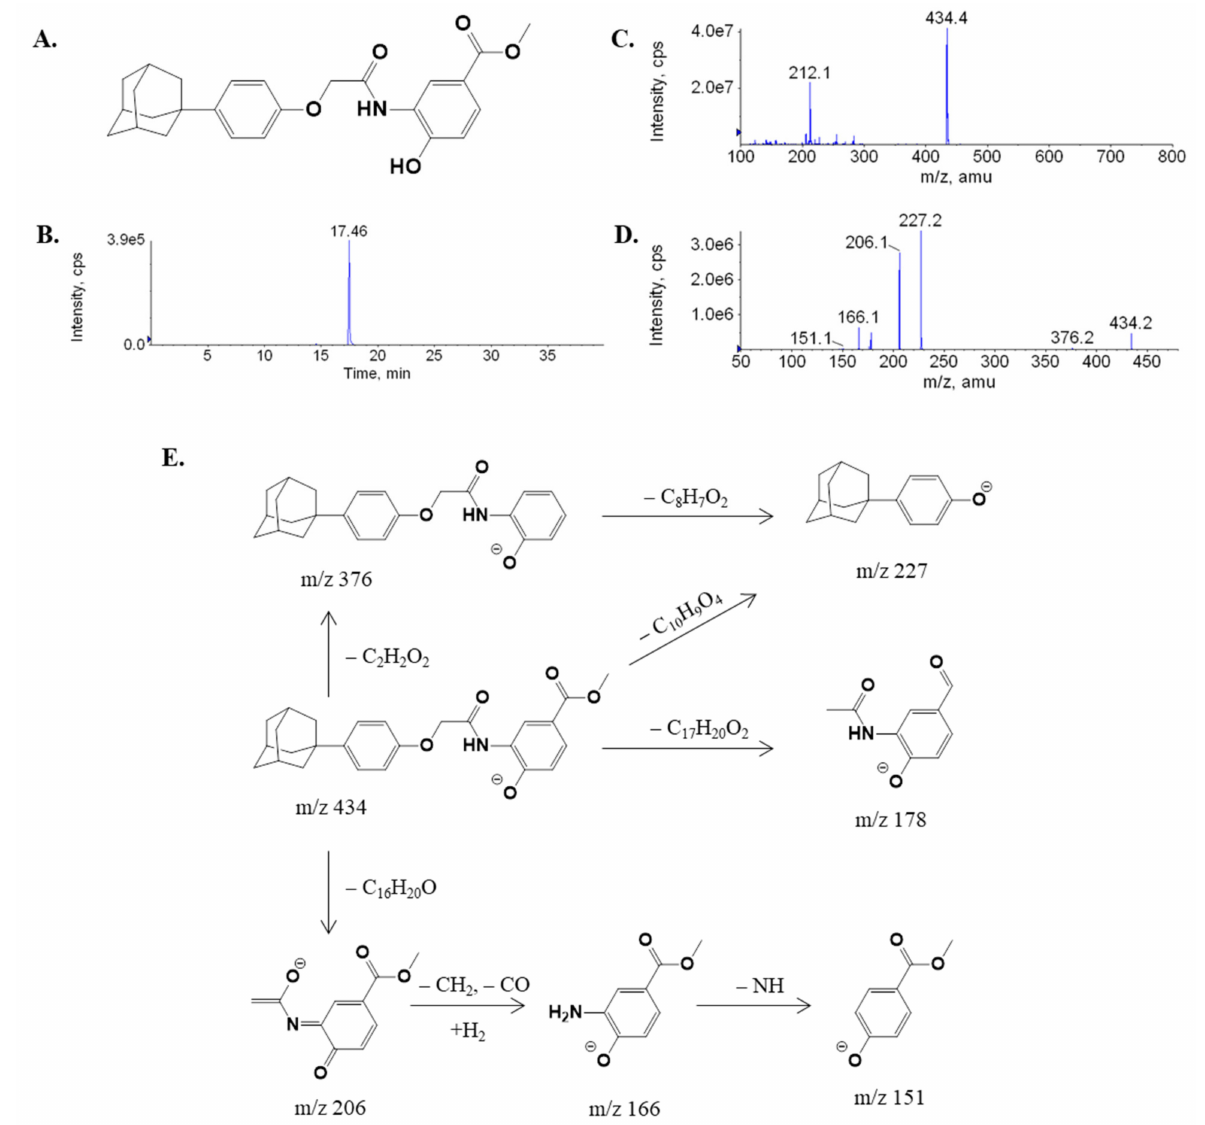
Figure 1. Structure ( A ), chromatogram ( B ), full-scan mass spectrum ( C ), enhanced product ion (EPI) spectrum at m/z 434 ( D ), and predominant fragmentation patterns for (aryloxyacetylamino)benzoic acid derivative (LW6) ( E